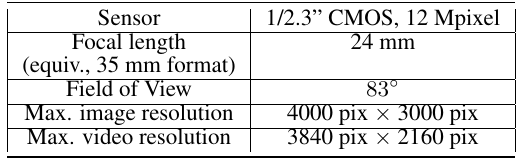
Table 1. DJI Mini 2 camera characteristics.